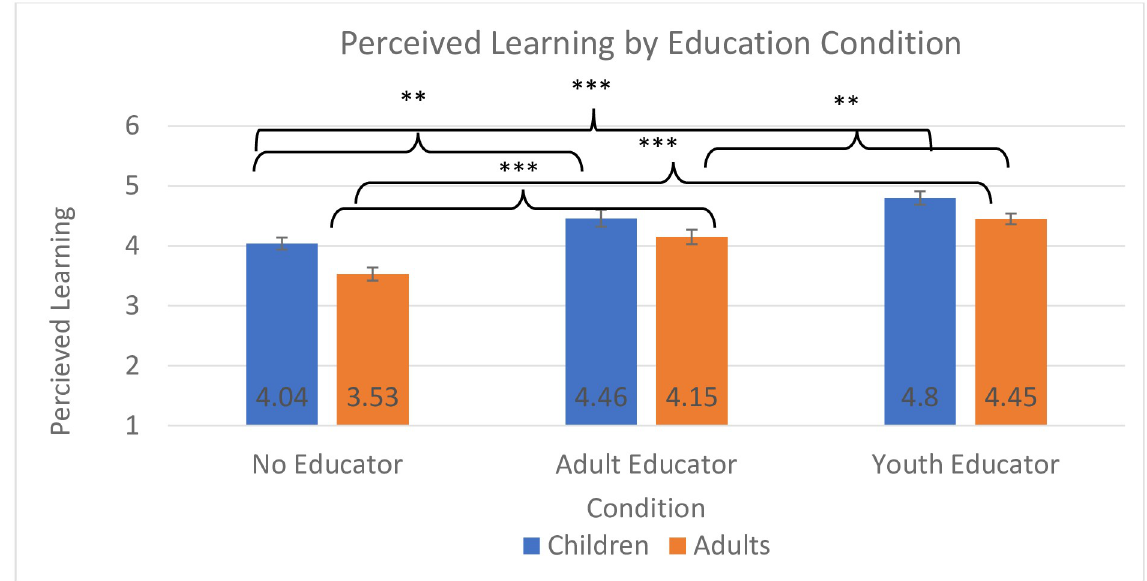
Fig 4. Perceived learning by education condition. Analyses for children and adults were conducted separately, but are displayed in one graph for ease of interpretation across analyses; � p < .005, �� p < .01, ��� p < .001.